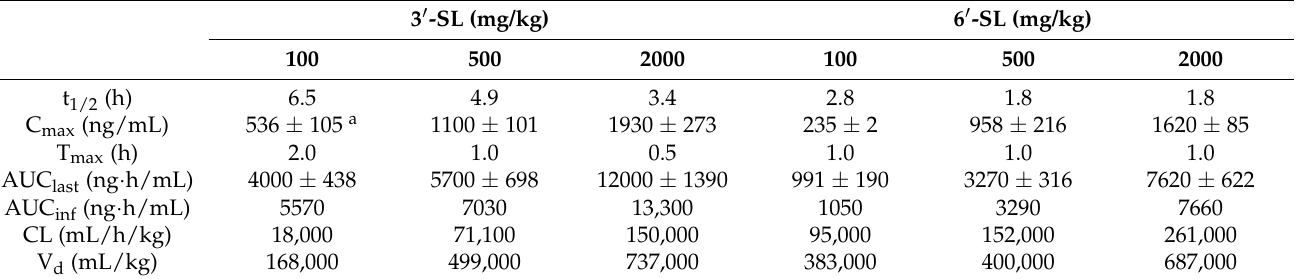
Table 6. Pharmacokinetic parameters following oral dosing of 3 (cid:48) -SL and 6 (cid:48) -SL in male